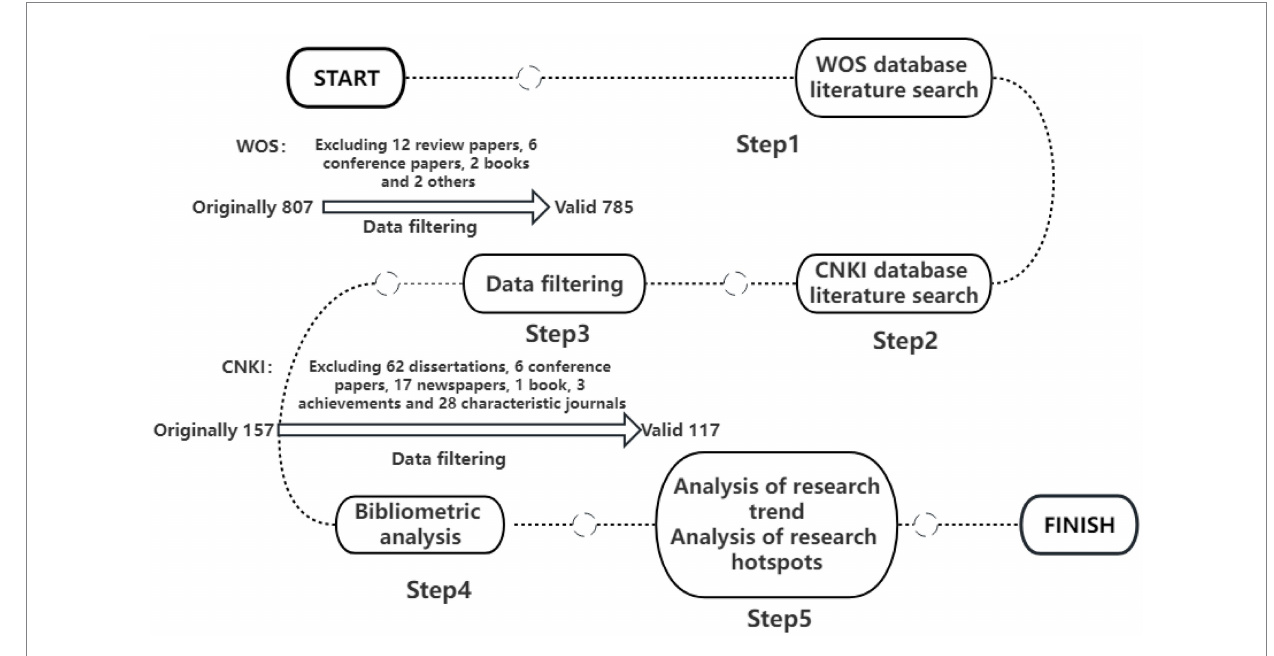
FIGURE 1 Research methods and steps.